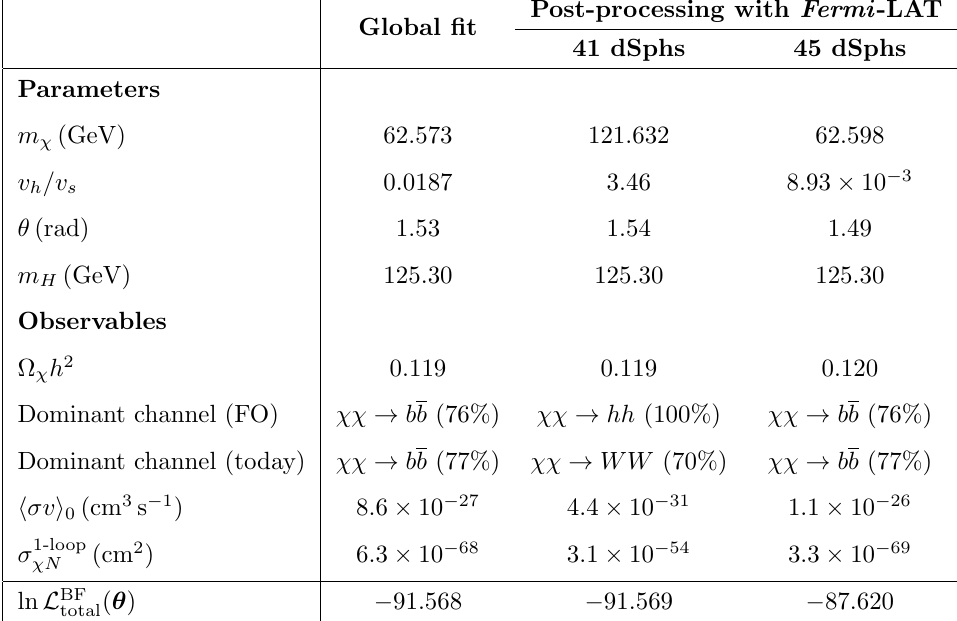
BF ( (cid:18) ) from total L